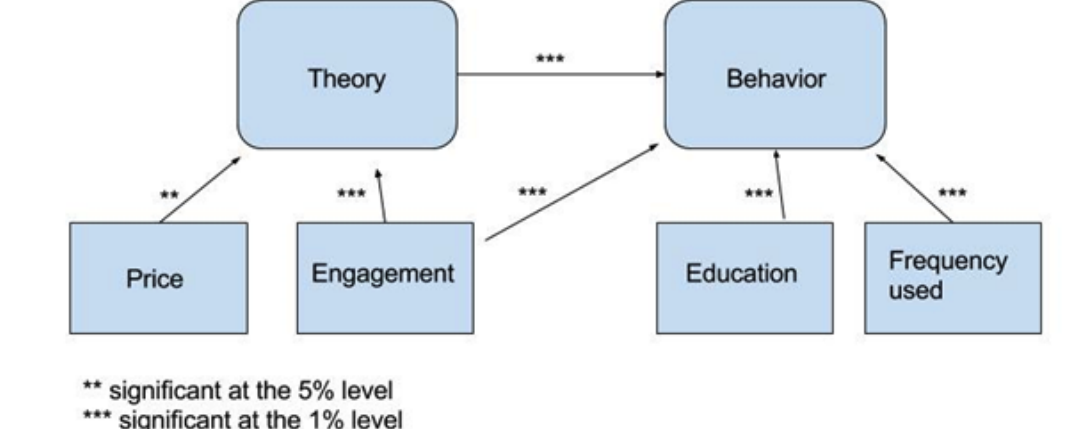
Figure 1. Factors influencing behavior change. Figure 1 illustrates the relationship between mobile application attributes, theoreticaldeterminants of behavior and behavior. Arrows indicate the hypothetical direction of therelationships and stars indicate the statistical